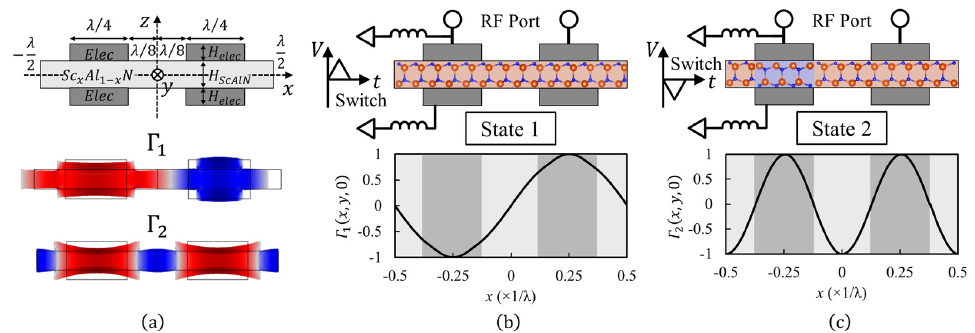
Figure 1. ( a ) Cross − sectional schematic of unit-cell in the Lamb-wave resonators, with strain mode − shapes when operating in Γ 1 and Γ 2 modes. ( b ) Operation State 1 (unified polarization): polarization under all the IDTs is in same direction, enabling the high- k 2 excitation of Γ 1 while Γ 2 mode is turned off. ( c ) Operation State 2 (alternating polarization): polarization under consecutive IDTs is in the opposite direction, enabling the high- k 2 excitation of Γ 2 while Γ 1 mode is turned off.